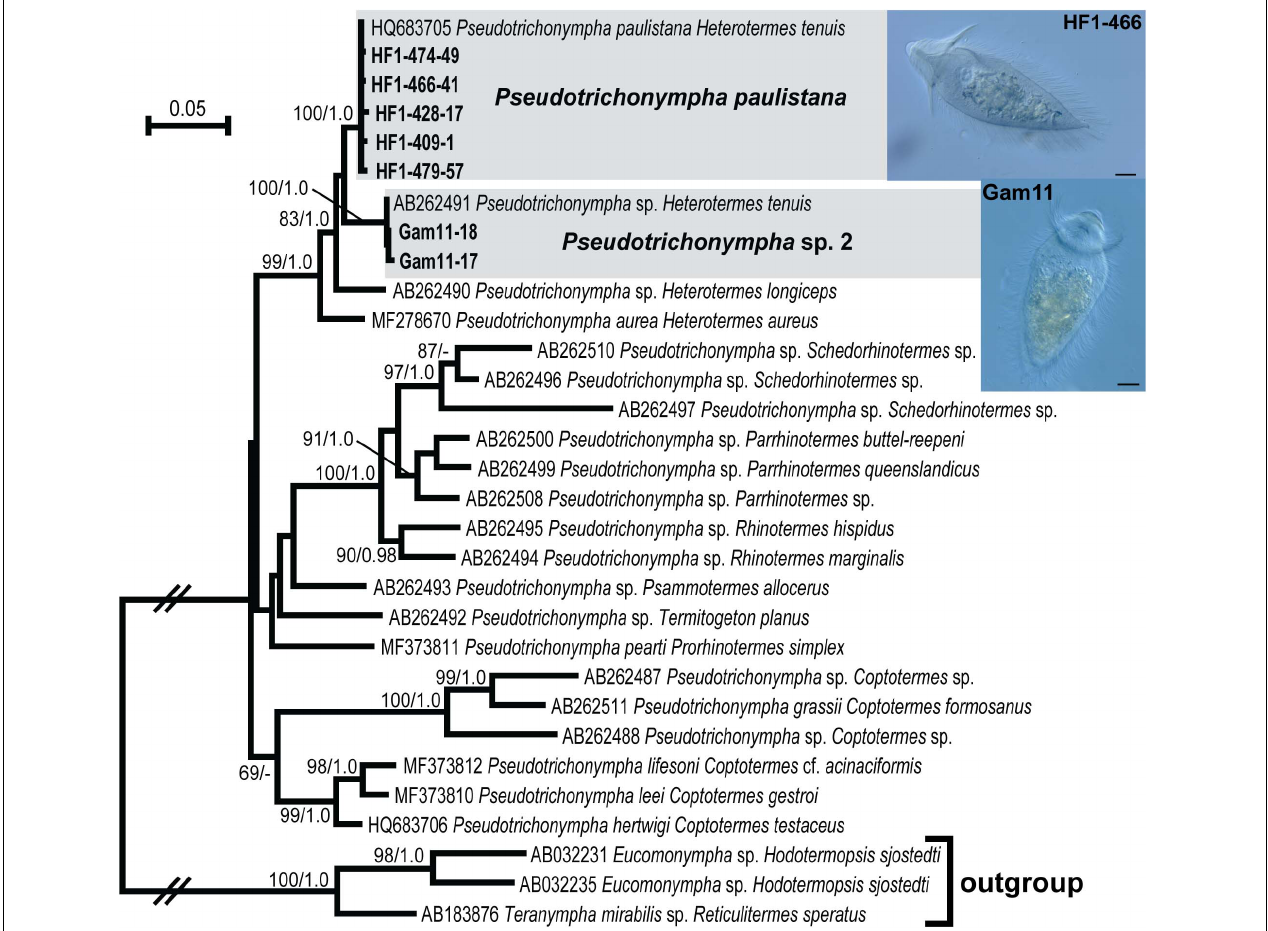
FIGURE 2 | Maximum likelihood phylogeny of 18S ribosomal RNA gene sequences from Pseudotrichonympha with outgroup Eucomonympha and Teranympha (Teranymphidae: Trichonymphida). Protist species-level phylotypes from H. tenuis are indicated by gray boxes and new sequences obtained in this study are indicated by bold text. Support at nodes is given out of 100 bootstrap replicates computed by RAxML/Bayesian posterior probabilities if greater than 60/0.95. New sequences from H. tenuis symbionts are indicated by bold text. Select cells from which new sequences were derived are shown in micrographs inset at right; sequence names (tip labels) include the cell code. All scale bars: 20 µ